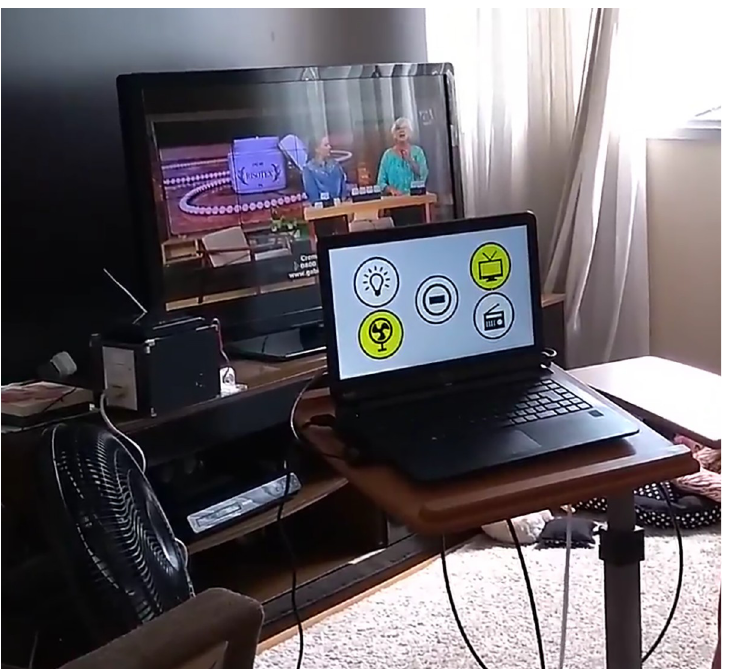
Fig 4. System installed in the home of one of the study